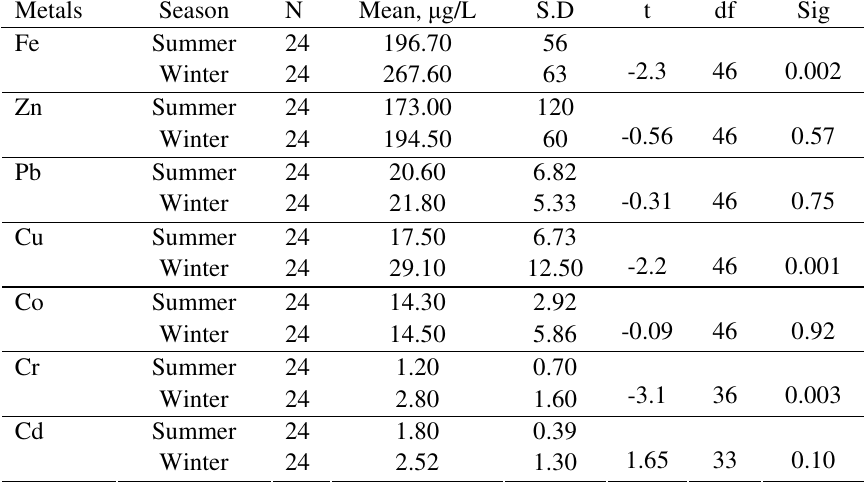
Table 4. Statistical difference between the average concentration of the trace metals in wastewater effluent for both